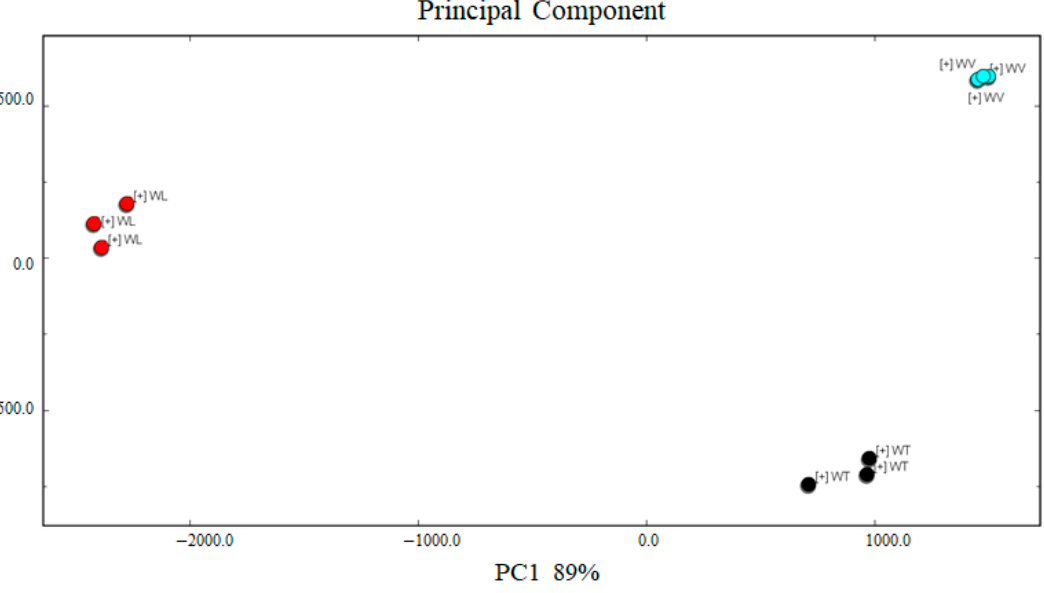
Figure 7. The Gallery Plot of volatile compounds in cherry wines derived from three cultivars.